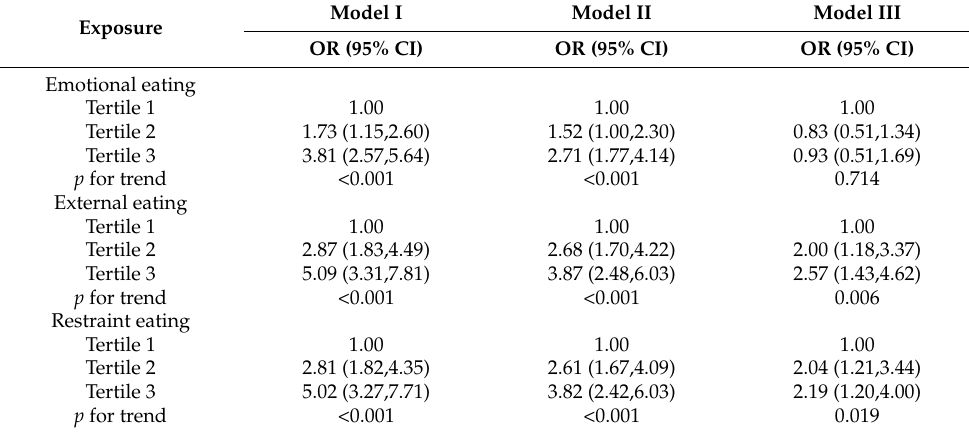
Table 4. Association between different eating styles and irritable bowel syndrome in different models ( n = 2739).